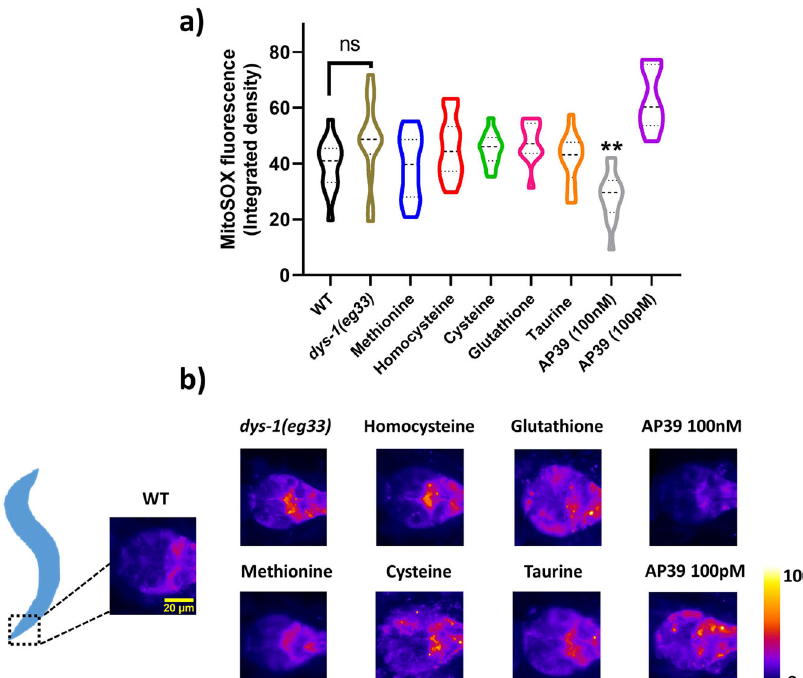
Fig. 6 Mitochondrial superoxide production in dys-1(eg33) mutants is not altered with SAA exposure. a dys-1(eg33) animals do not display a signi fi cant increase in MitoSOX fl uorescence within the terminal bulb of the pharyngeal muscles compared to wt animals, despite a visual trend for increased fl uorescence intensity. SAA did not alter the fl uorescence signal, however, 100 nM AP39 signi fi cantly lowered mitochondrial superoxide (but not 100 pM) to dys-1(eg33) controls. Scale bar: 20 µ m. b Representative images using a fi re LUT to enhance visual clarity of MitoSOX fl uorescence. Data are presented as violin plots to display the distribution of the data. Dashed lines represent the median and quartiles are represented by the dotted lines. Data are obtained from two biological repeats with 20 – 30 animals per condition. Asterisks denote signi fi cance to dys-1(eg33) control animals. ** P < 0.01, **** P <